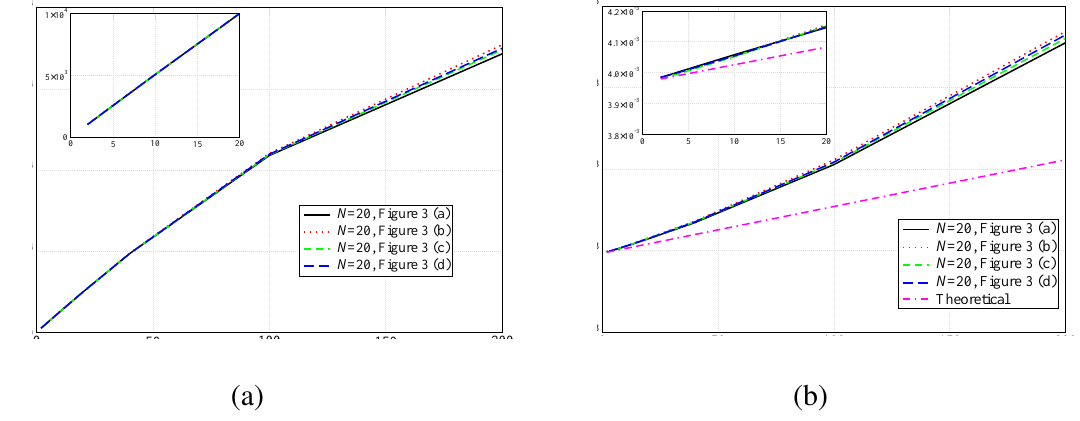
Figure 11. (a) Network transmission rate and (b) delay as functions of the aggregated offered traffic load Ng . Various topologies with N = 20 nodes are considered. The sparsity index is set at 0.87.